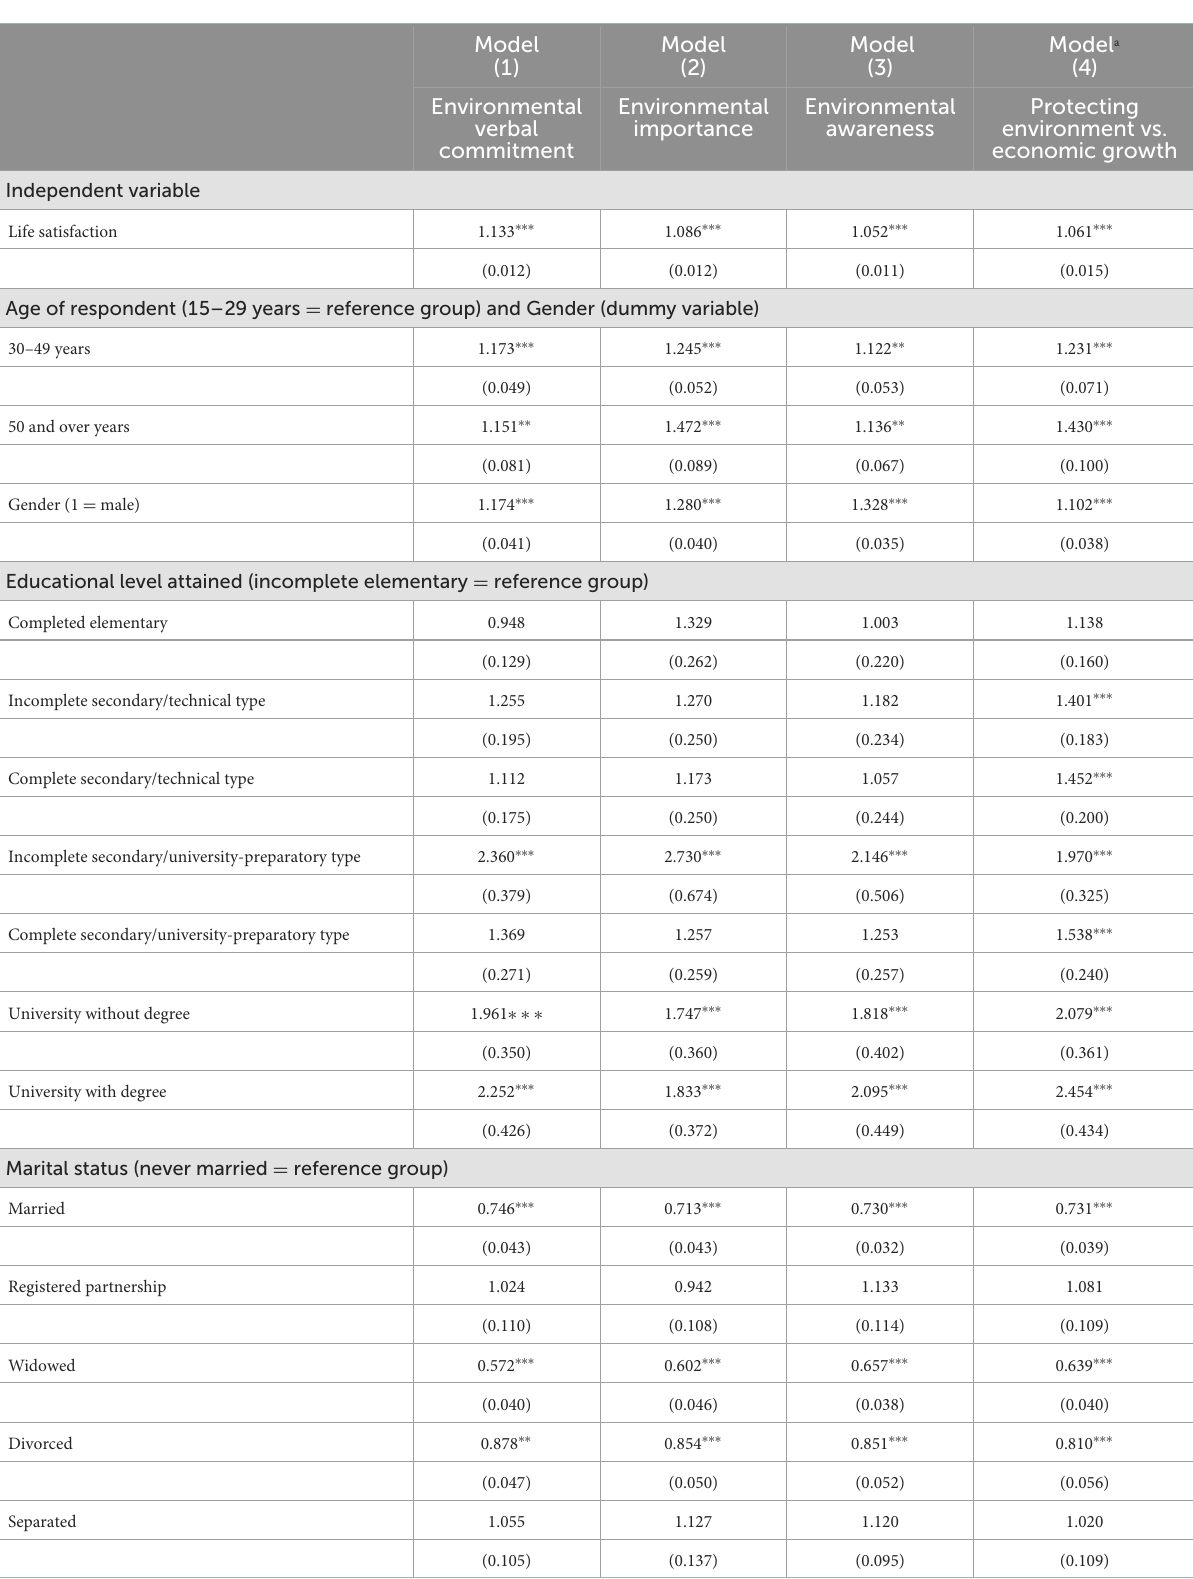
TABLE 1 Baseline